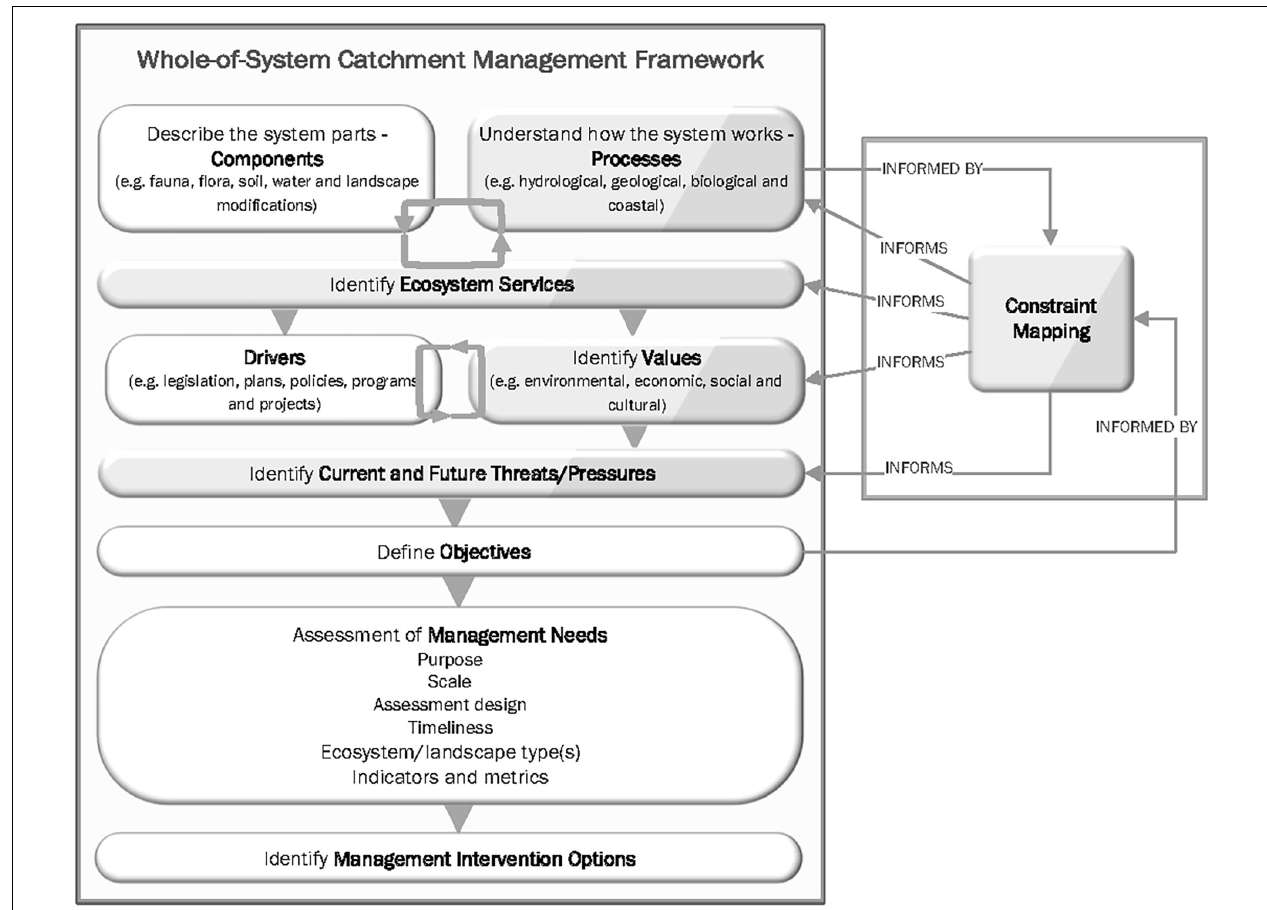
BOX 1 | Definition of terms. Ecological Constraint Mapping: An approach that focusses on identifying the factors that constrain life-history outcomes (success/productivity/resilience/fitness) of species or faunal groups. (abridged to “Constraint Mapping” for brevity). Constraint Network: A consolidation of information in the suite of Constraint Maps for an area to enable assessment of the key constraints on ecological outcomes relative to a specific issue or concern. Habitat Features: The term “habitat” means different things to different people in different contexts (Hall et al., 1997). As a result, for clarity, we have used the term “habitat features” defined as areas of geological/geomorphological (e.g., boulders, gravel, rock, sand, clay) or biological (e.g., snags, in-water vegetation), hydrodynamic (e.g., plume front) components utilized by an organism, and defined at a scale relevant to the size and activity of the species in question. For example: a single mangrove root might provide usable habitat structure for a gastropod, a whole mangrove tree root complex for a crab, and a whole mangrove stand for a large (10-100 cm length) mangrove dwelling fish (e.g., Department of Environment and Science, Queensland, 2019). Habitat Mosaics: Groups of Habitat Features, and the complex spatio-temporal connections among them, that support particular life-history stages. Species Requirement Set: The complete set of requirements for a species to occur at a particular location based on all the situations and locations in which it occurs. Structural Spatial Map: A geospatial representation of the habitat features in the area of interest for Constraint